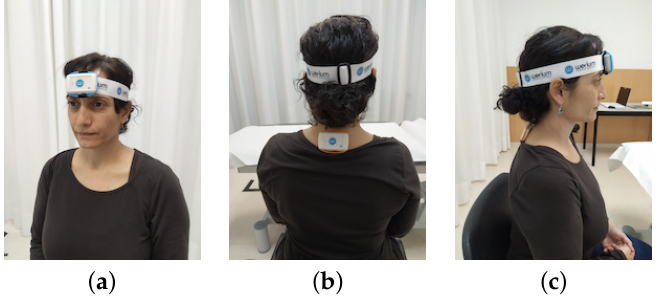
Figure 9. Placement of the inertial sensors: ( a ) sensor 1 ( b ) sensor 2 ( c ) sensor 1 and sensor 2.